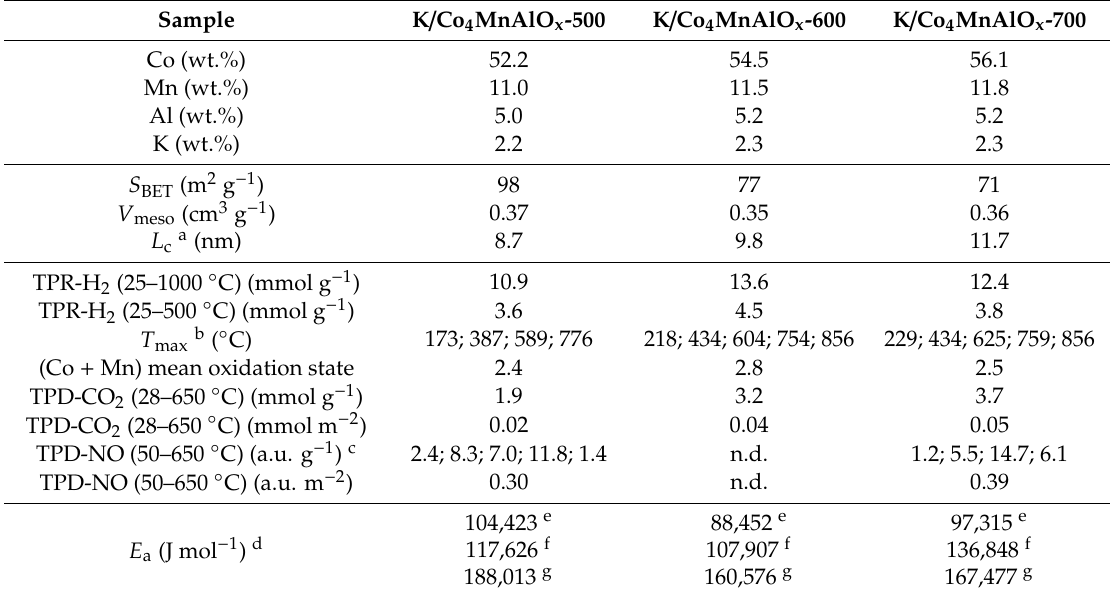
a Mean crystallite size calculated from half-width of XRD peak S (311) using Scherrer’s formula. b Temperature maxima of reduction peaks from TPR-H 2 . c Area of individual peaks after deconvolution of NO signal. d Apparent activation energy evaluated from Arrhenius plot ln( k ) = f(1 / T ). e 0.1 mol. % N 2 O balanced by He. f 0.1 mol. % N 2 O + 5 mol. %